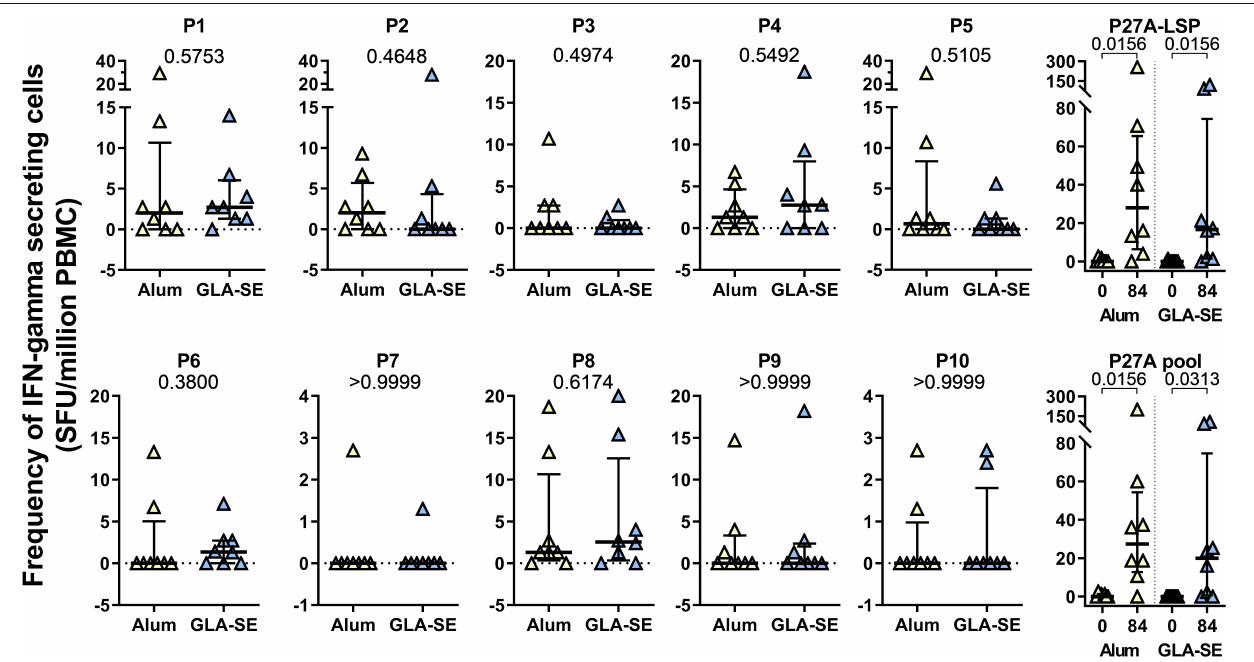
FIGURE 1 | Cellular responses to P27A and overlapping 20-mers at D84 in Phase 1a. PBMC from unexposed volunteers (CH-Alum/50 ( n = 8) and CH-GLA2.5/50) ( n = 8) at D84 were stimulated with P27A-LSP or the overlapping 20-mer peptides P1 to P10, individually or as a pool. The frequency of IFN- γ secreting cells was revealed by ELISPOT. Results are expressed as SFU/ million PBMC. Comparisons between groups were done using Mann-Whitney test; p- values are indicated. Responses at D0 and D84 to P27A-LSP and the pool of peptides are shown with Wilcoxon test p